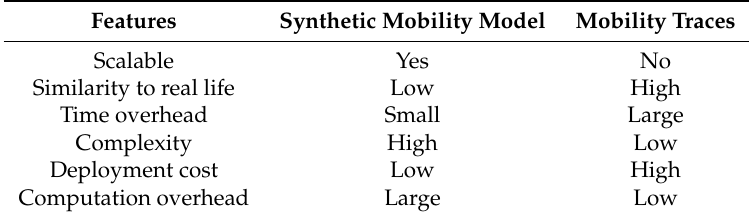
Table 1. Comparison of mobility traces (real deployment) and synthetic model (software